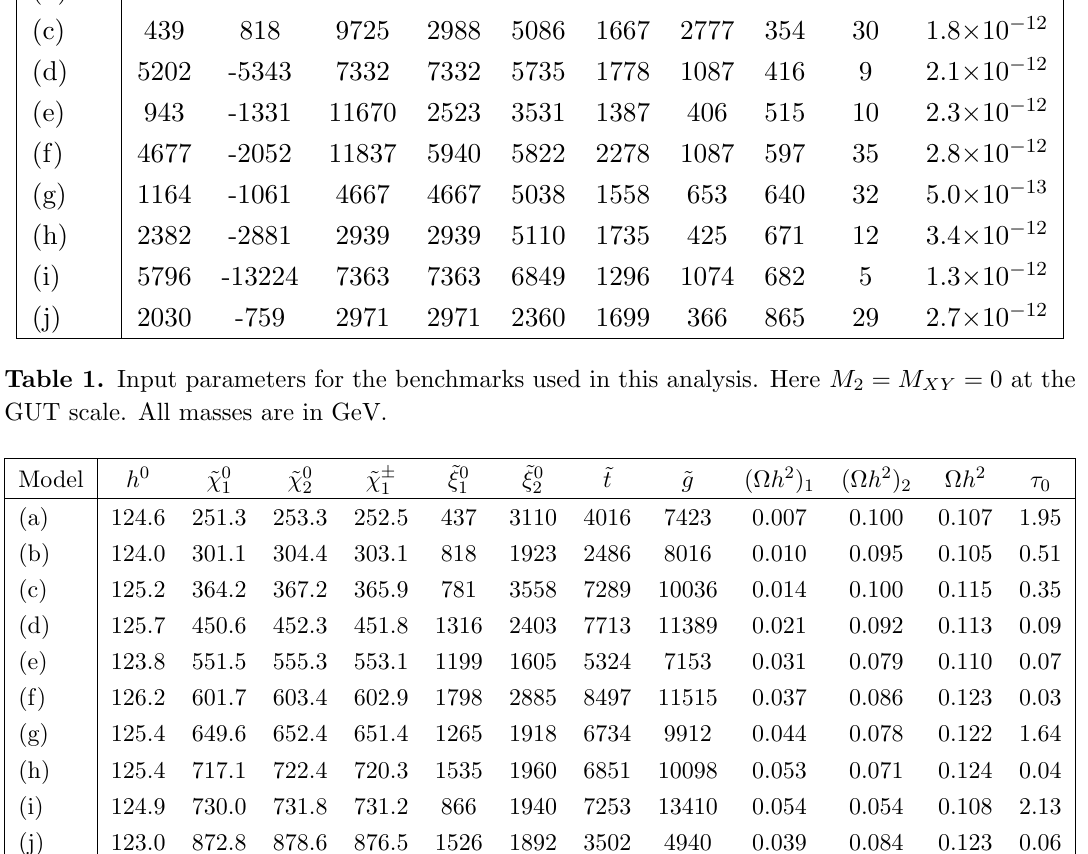
; (cid:24) 0 masses, and the relic density 1 2